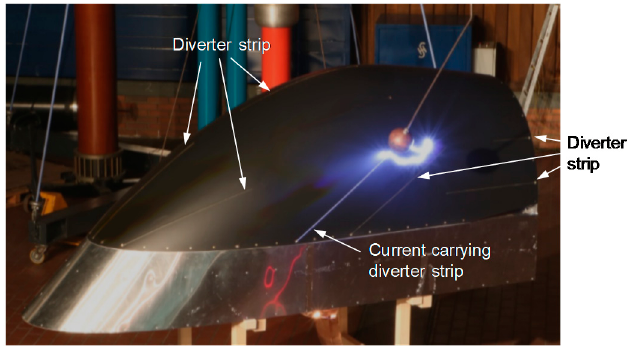
Figure 8. Image of the SATCOM radome prototype during the test with waveform D [29].